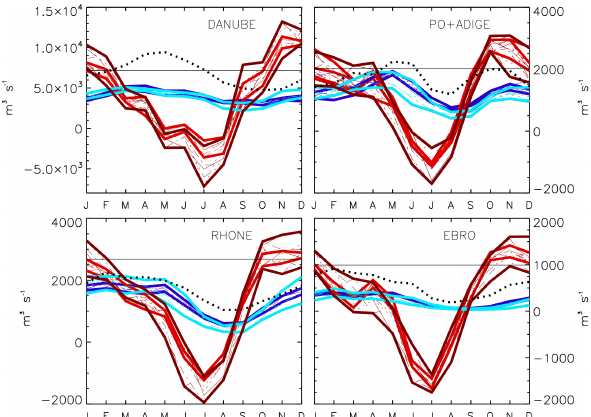
Figure 5. Basin-wide seasonal cycles of key water balance compo- nents ( P − E : present – red, future + 2 ◦ C – blue, runoff: present – orange, future + 2 ◦ C – light blue). Thick lines outline the envelop of the five ensemble members, while thin lines correspond to sin- gle realizations. The black dotted line represent observed discharge. The black horizontal line represents average of the P − E over the 1971–2005 period using uncorrected (supposedly biased) precipi- tation along with evapotranspiration estimates from the corrected temperature